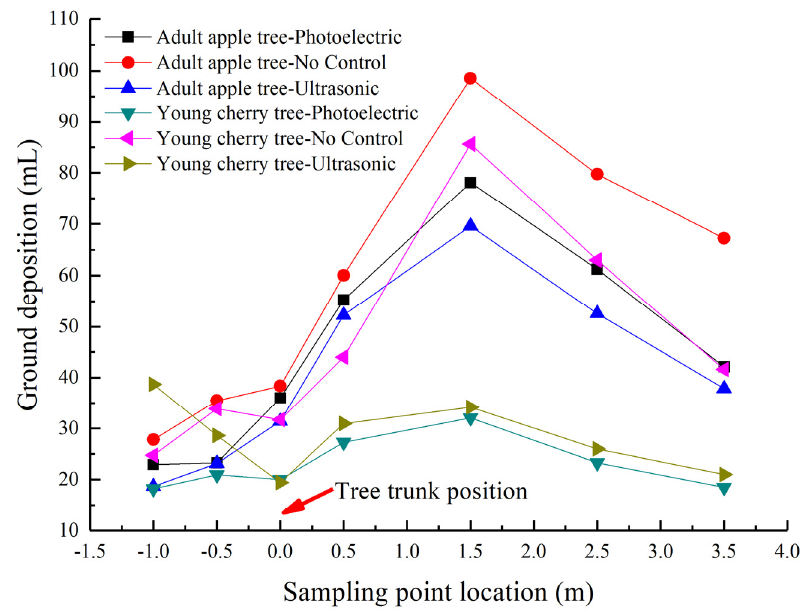
Figure 13. Deposition variation at different positions on the ground: the negative values of the abscissa represent the sampling point locations in front of the trunk in the spray direction, and the positive values represent the sampling point locations at back of the trunk in the spray direction.